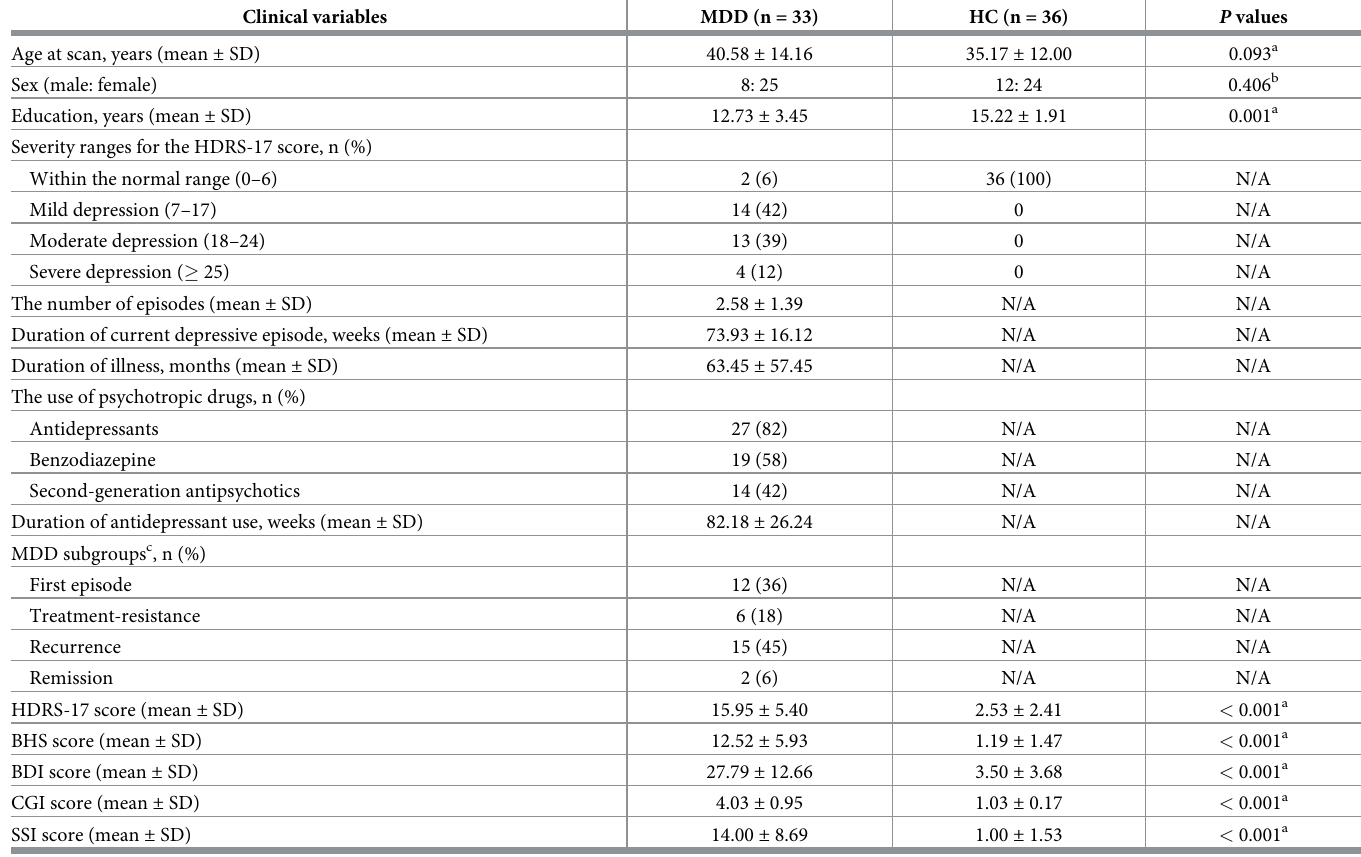
Table 1. Demographic and clinical characteristics of the MDD and HC groups. Clinical